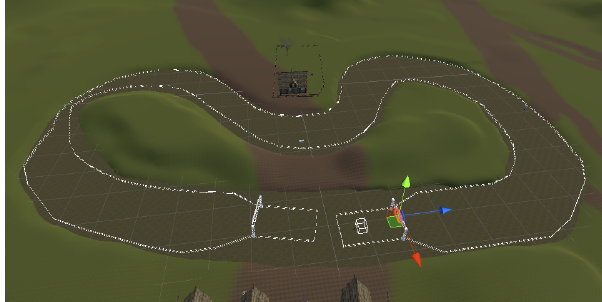
Figure 7. Virtual track traveled by users in the